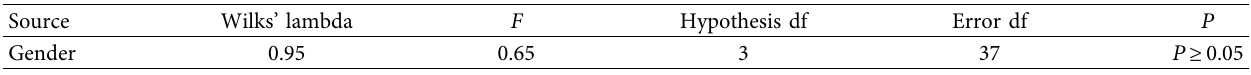
Table 3: Multivariate analysis of variance test results of the difference between male and female in the research help-seeking subscale table. Source